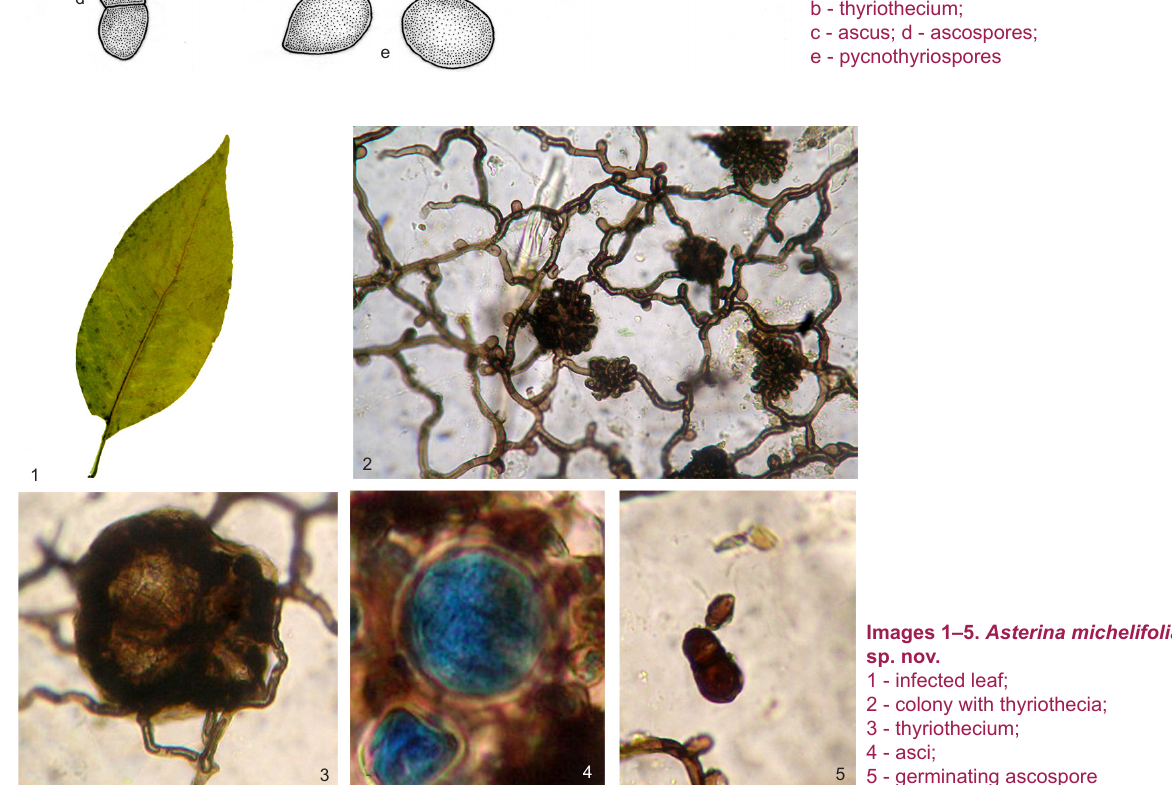
Figure 1. Asterina michelifolia sp. nov. a - apprassoriate